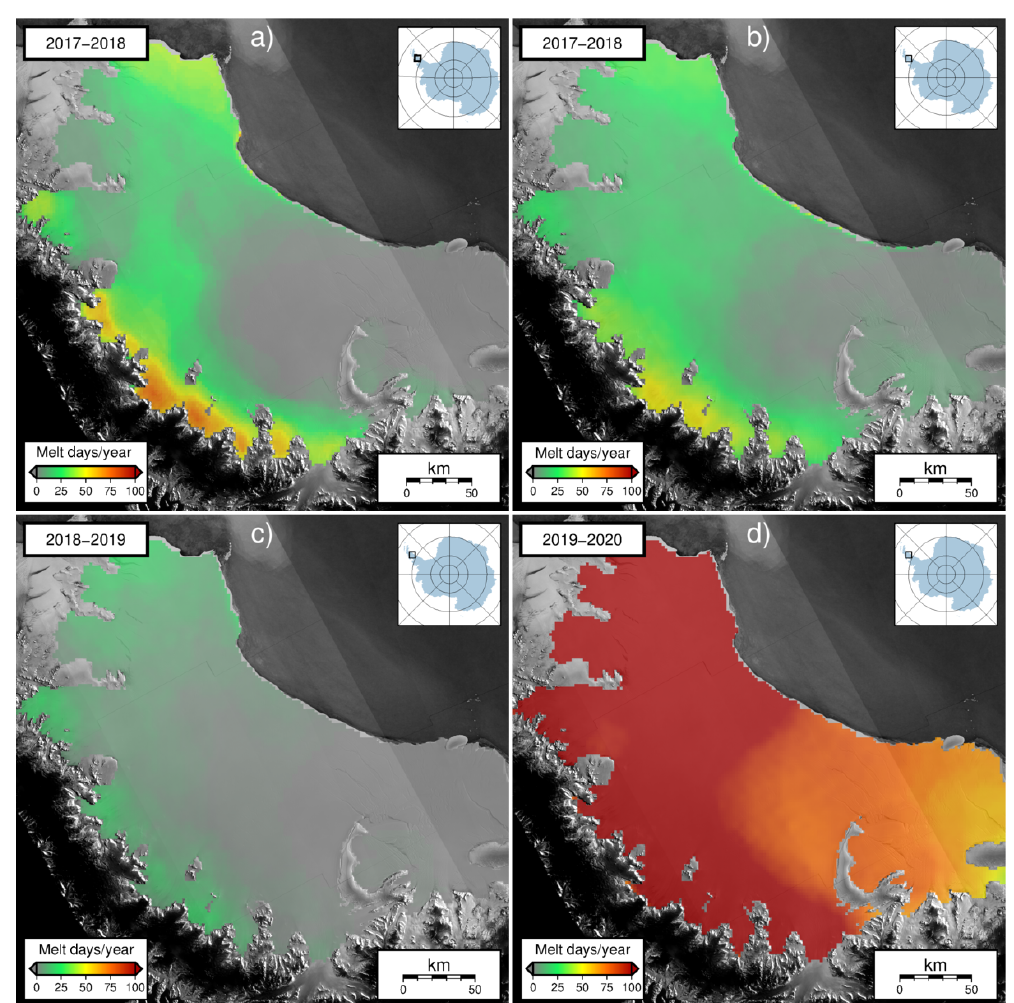
Figure 2. Number of melt days in (a) 2017/2018 based on SIR ASCAT data, (b) 2017/2018 based on Level 1 ASCAT data, (c) 2018/2019 based on Level 1 ASCAT data, and (d) 2019/2020 based on Level 1 ASCAT data. The background image is Copernicus Sentinel-1 2019 mean